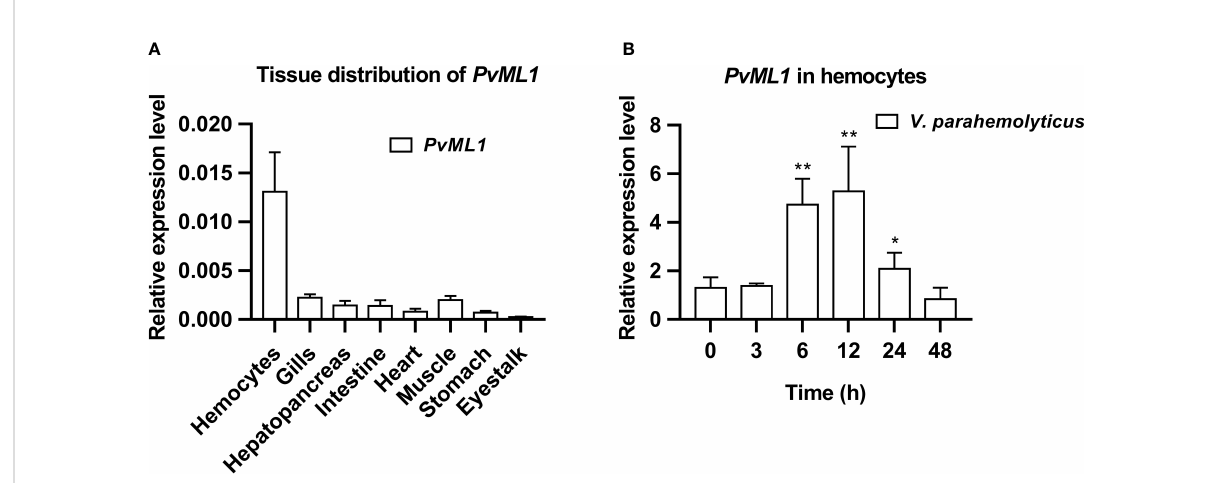
FIGURE 2 Tissue distribution and expression pro fi les of PvML1 . (A) Tissue distribution of PvML1 was analyzed using qRT-PCR with EF1 a as the internal reference. (B) Expression pro fi les of PvML1 in hemocytes at different time points after Vibrio parahemolyticus infection. Signi fi cant differences were indicated with asterisks (* P < 0.05; ** P <